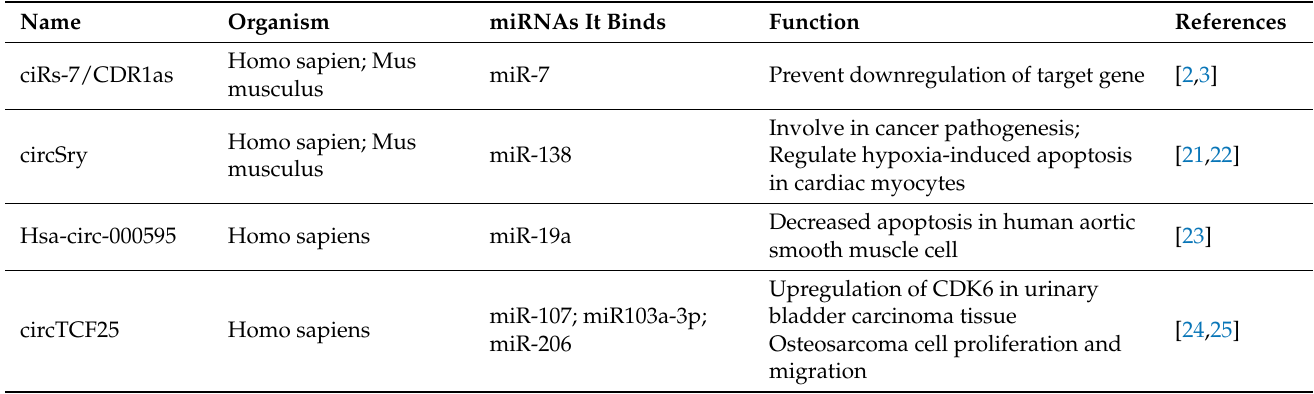
Table 1. Some circRNAs act as miRNA sponge and their